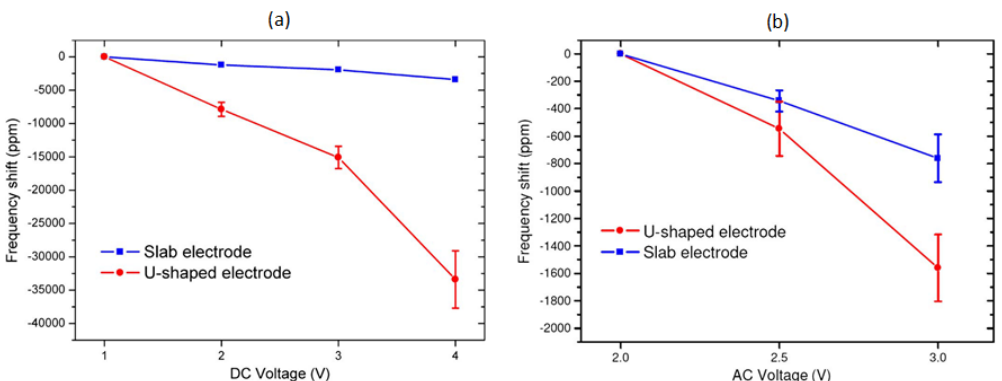
Figure 18. Measured resonant frequency shift of the bridge resonator in response to the change in ( a ) DC or ( b ) AC voltage applied to Pt electrodes for slab and u-shaped designs [27]. c (cid:13) 2012 IEEE. Reprinted, with permission, from Mastropaolo et al. J. Microelectromech. Syst. 21,